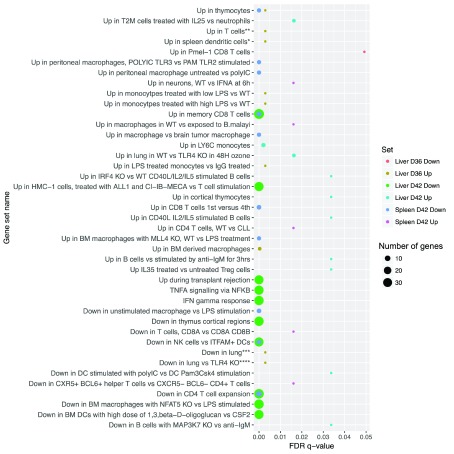
GSEA analysis of DE genes in spleen and liver after AmBisome
® treatment.Figure shows pathway enrichment for DE genes identified in
Extended data: Table S1, according to gene set and number of genes. Full descriptions of gene sets and analysis are provided in
Extended data: Table S2.